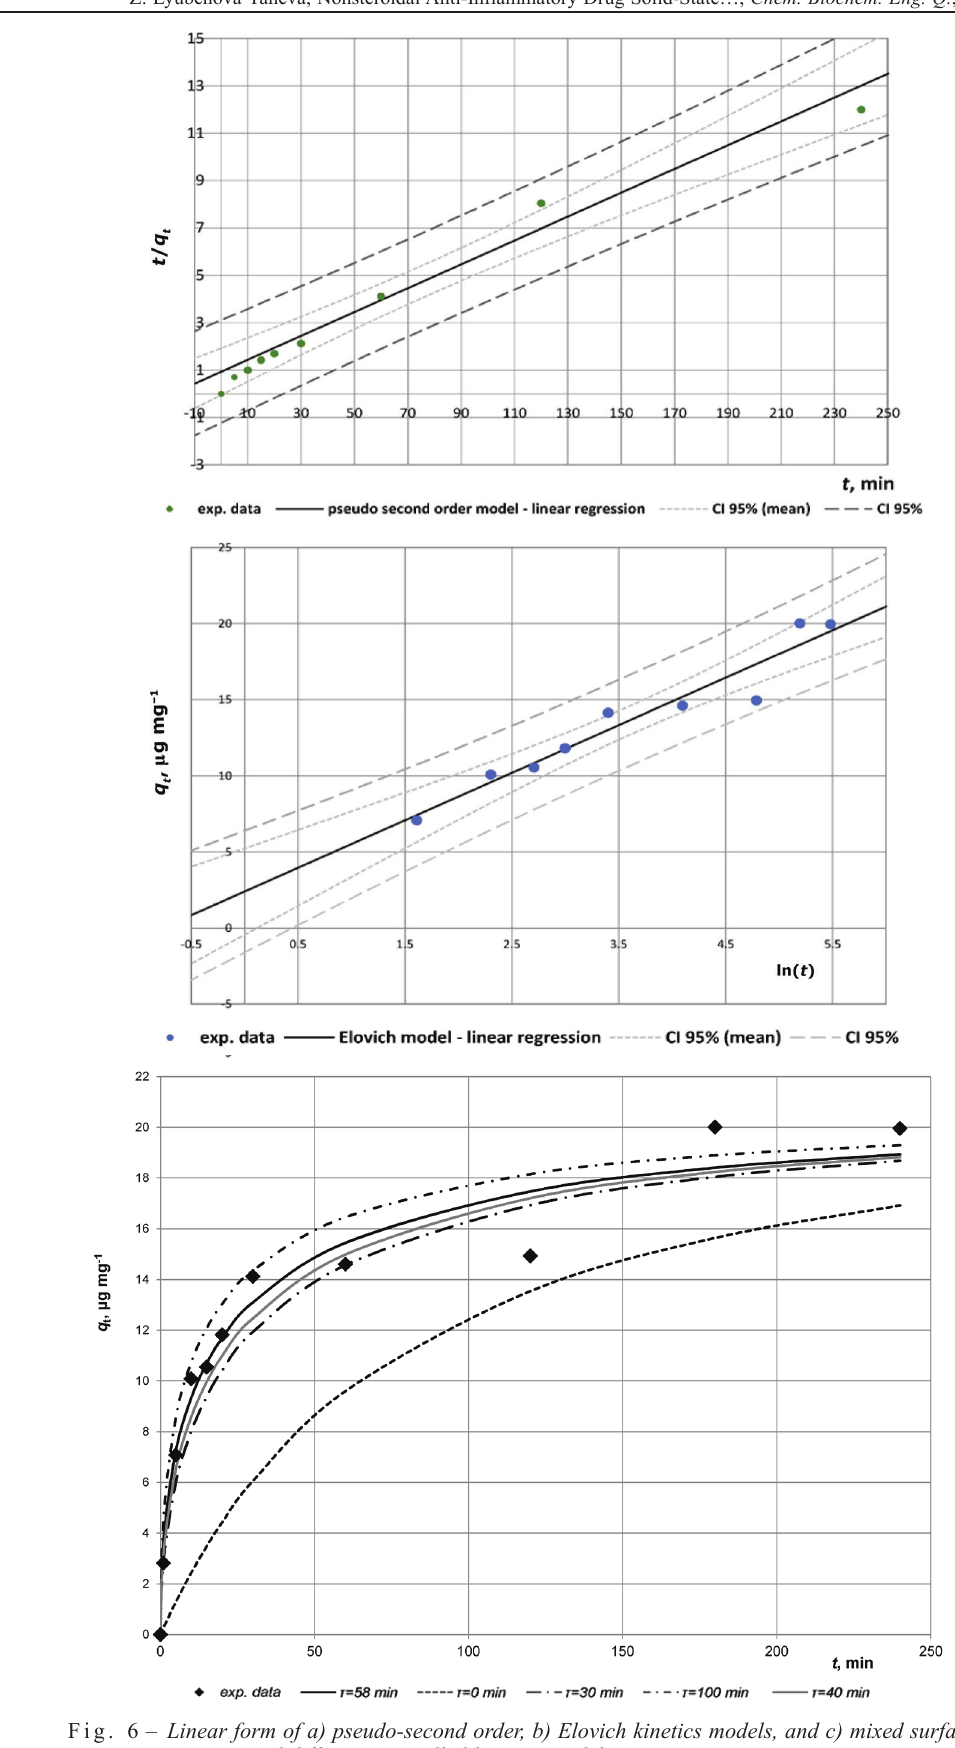
Fig. 6 – Linear form of a) pseudo-second order, b) Elovich kinetics models, and c) mixed surface reaction and diffusion controlled kinetics